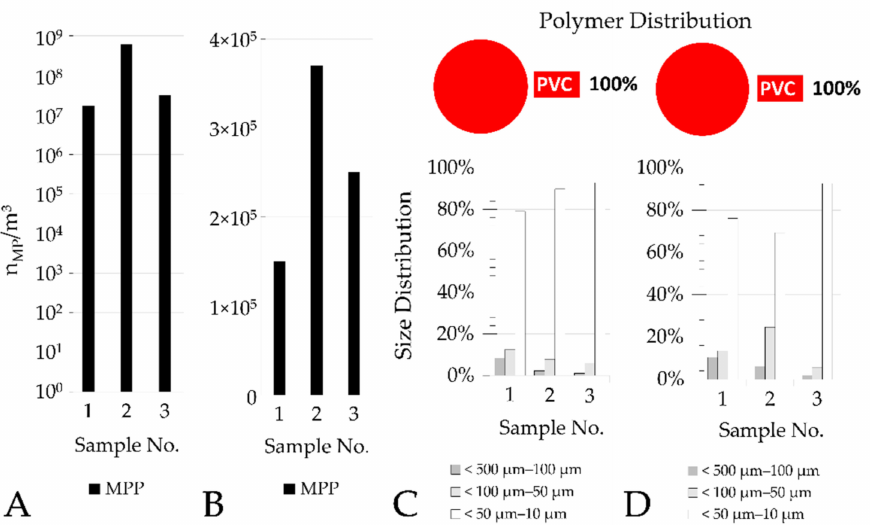
Figure 8. Identified polyvinyl chloride (PVC) MPP of samples 1–3 in process wastewater of a PVC manufacturer in the sand filter influent ( A ) and sand filter effluent ( B ); MPP polymer- and size distribution in samples 1–3 of the sand filter influent ( C ) and sand filter effluent ( D ) of the PVC manufacturer’s process